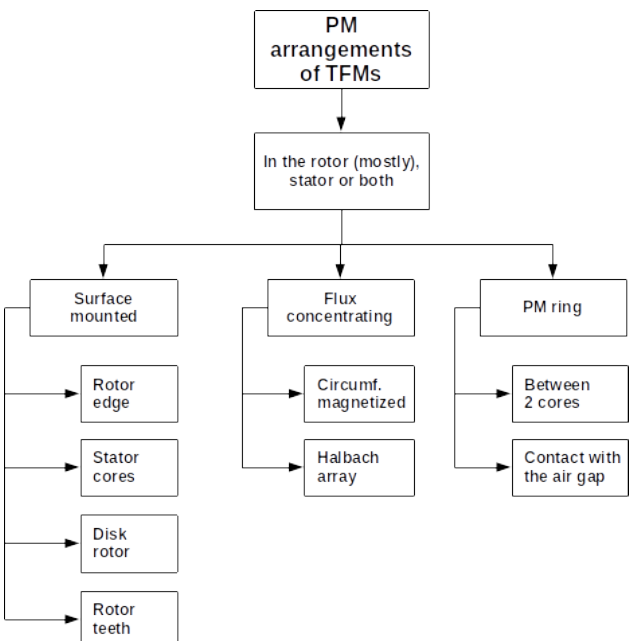
Figure 6. PM arrangements of TFMs.